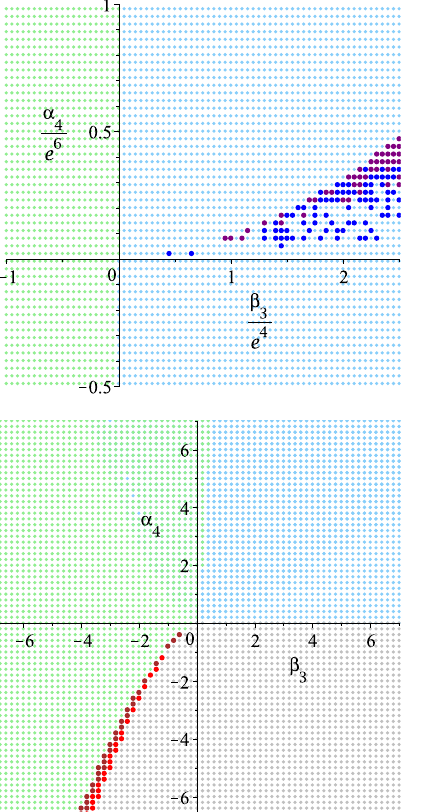
Even for e = 0, there are regions in the ( (cid:12)